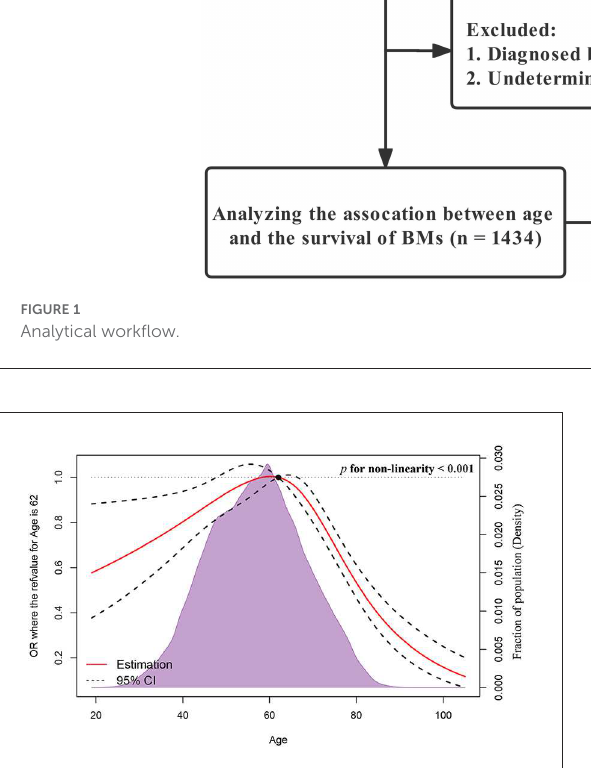
FIGURE2 Association between age and the presence of BCSBMs using a restricted cubic spline regression